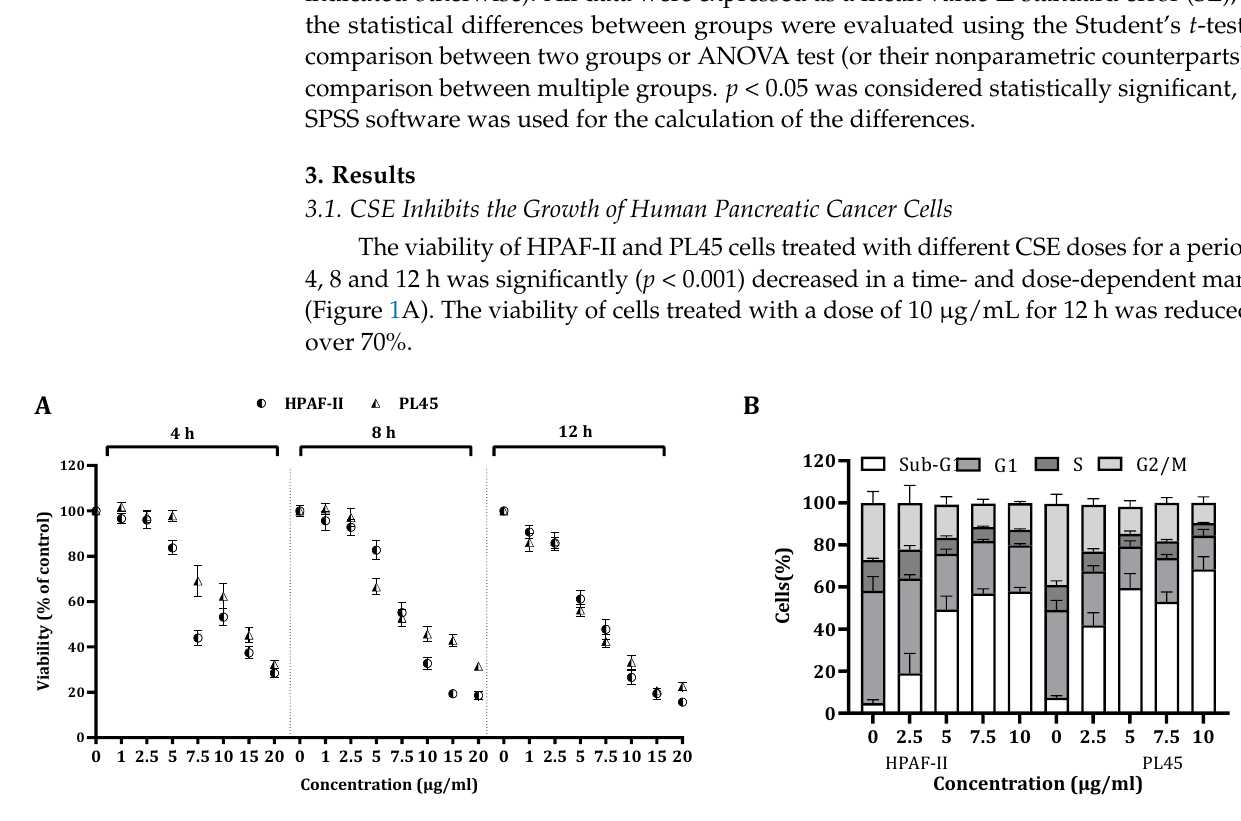
Figure 1. The effect of CS on cell viability and cell cycle progression. ( A ) HPAF-II and PL45 human pancreatic cancer cells were treated with 2.5, 5 and 10 µ g/mL for 4, 8 or 12 h, followed by cell viability assessment using the XTT assay, as described under “Materials and Methods”. ( B ). Distribution of HPAF-II and PL45 cells at the sub-G1 phase of the cell cycle following CSE treatment with 2.5, 5 and 10 µ g/mL for 4 h. At the end of the treatment, cells were harvested, fixed and stained with PI and subjected to a cell cycle analysis using FACS Calibur (Becton Dickinson, Franklin Lakes, NJ, USA). Statistical significance was determined by one-way ANOVA or the Kruskal–Wallis test, p < 0.05, and Mann–Whitney for the post hoc, p <